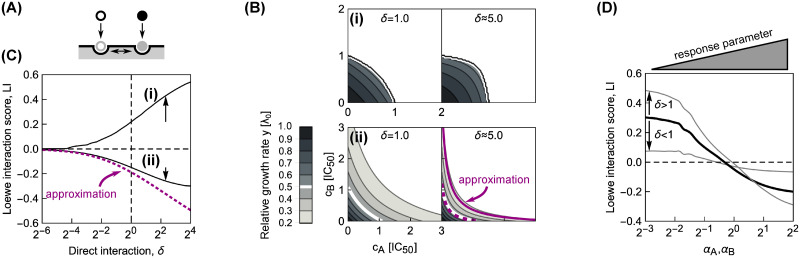
Direct interactions between antibiotics on the ribosome can amplify drug interactions.(A) Schematic of antibiotics symmetrically affecting their binding on the ribosome. (B) Changes in the shape of the dose-response surfaces for pairs of antibiotics with (i) identical α = 2−5 and (ii) identical α = 22, when δ is increased from 1 (left) to ≈5.0 (right). Purple dashed and solid line in the bottom-right panel show the approximate solution in Eq (14) for the 50% and 20% isoboles, respectively. (C) Increase in absolute value of the LI score as a function of δ for pairs of antibiotics with different response parameters. Solid lines (i) and (ii) correspond to the examples in (B); arrows show increase in |LI| at δ ≈ 5.0. Note, that for both antibiotic combinations, LI collapses to 0 for competitive binding, i.e., δ = 0. The dotted line shows the LI score calculated using the approximate solution in Eq (14). (D) Diagonal cross-section (αA = αB) through the phase diagram for different δ. Black solid line corresponds to the case of independent binding (cf. Fig 3C); the two gray lines show examples with either δ < 1 or δ > 1. Irrespective of drug interaction type, the drug interaction is amplified for δ > 1 and weakened for δ < 1.